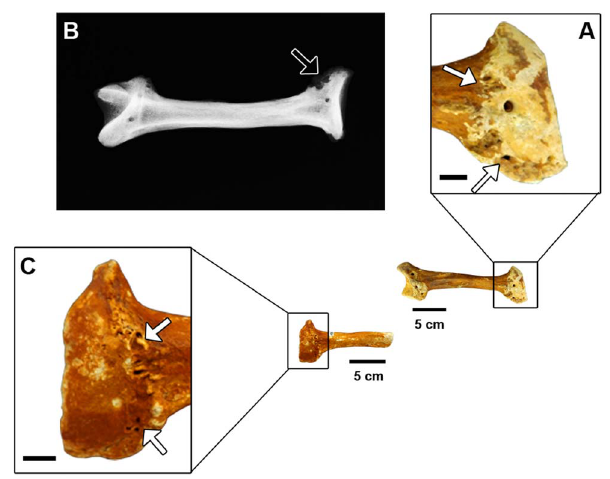
Figure 3. Radii of Glyptotherium . (A) A detail of the proximal epiphysis of the right radius MCC 481-V in caudal view; (B) Cranio- caudal radiography of the right radius MCC 481-V; (C) A detail of the proximal epiphysis left radius MCC 482-V in caudal view. Scale bars in the details A and C=1 cm.